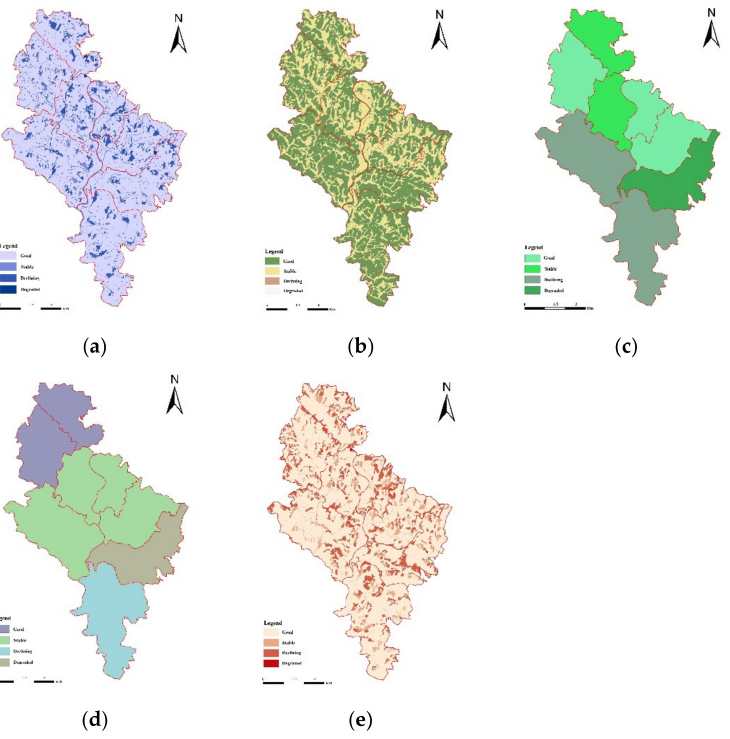
Figure 7. Evaluation results of the ecological environmental effect status of rural land use in 2019. ( a ) Resource effect status in 2019; ( b ) environmental effect status in 2019; ( c ) social effect status in 2019; ( d ) economic effect status in 2019; ( e ) ecological environment effect status in